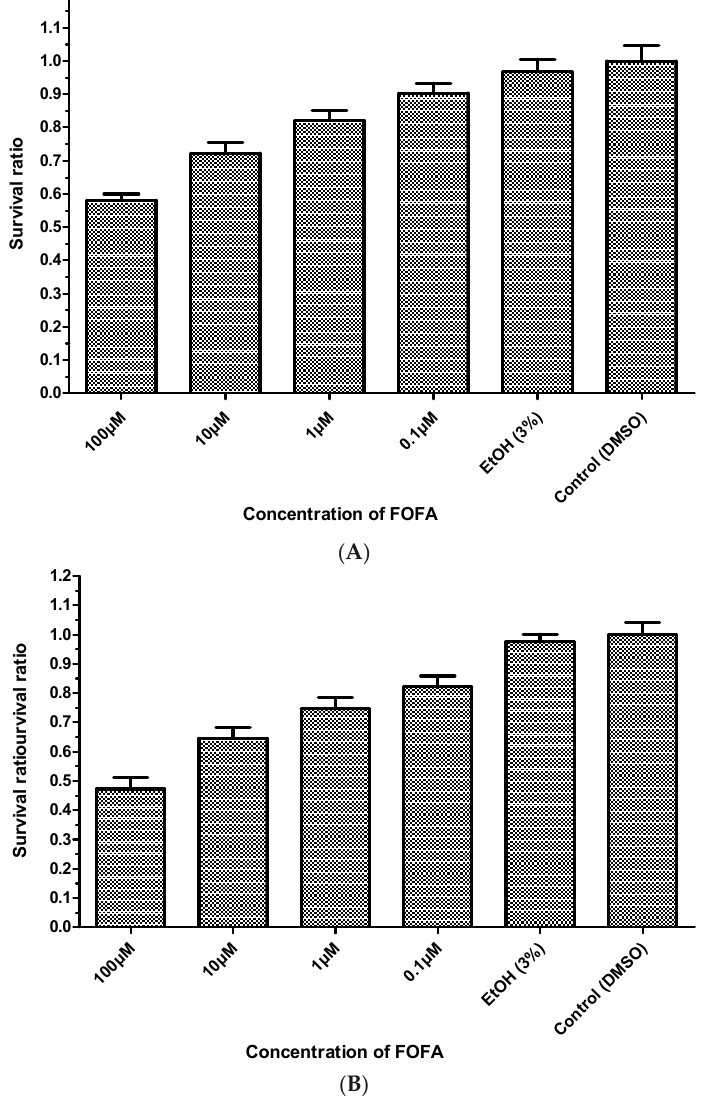
Figure 4. Cell survival assay of FOFA {[ 18 F]- 1 } in ( A ) fibroblast (a control) and ( B ) C6 glioma tumour cells after 48 h.